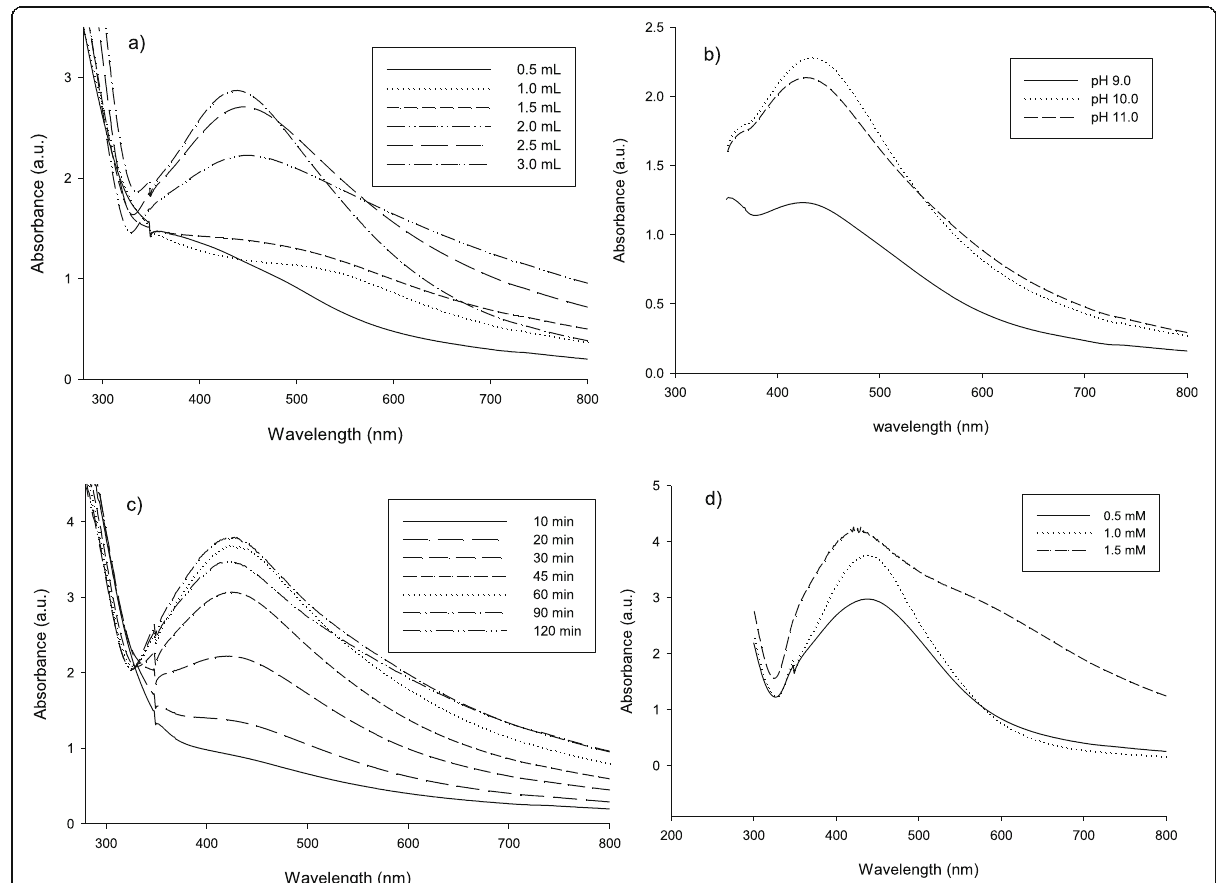
Fig. 2 UV – visible absorption spectra of AgNP biosynthesis optimization at different: a CFF volumes, b pH values, c reaction time, and d silver nitrate